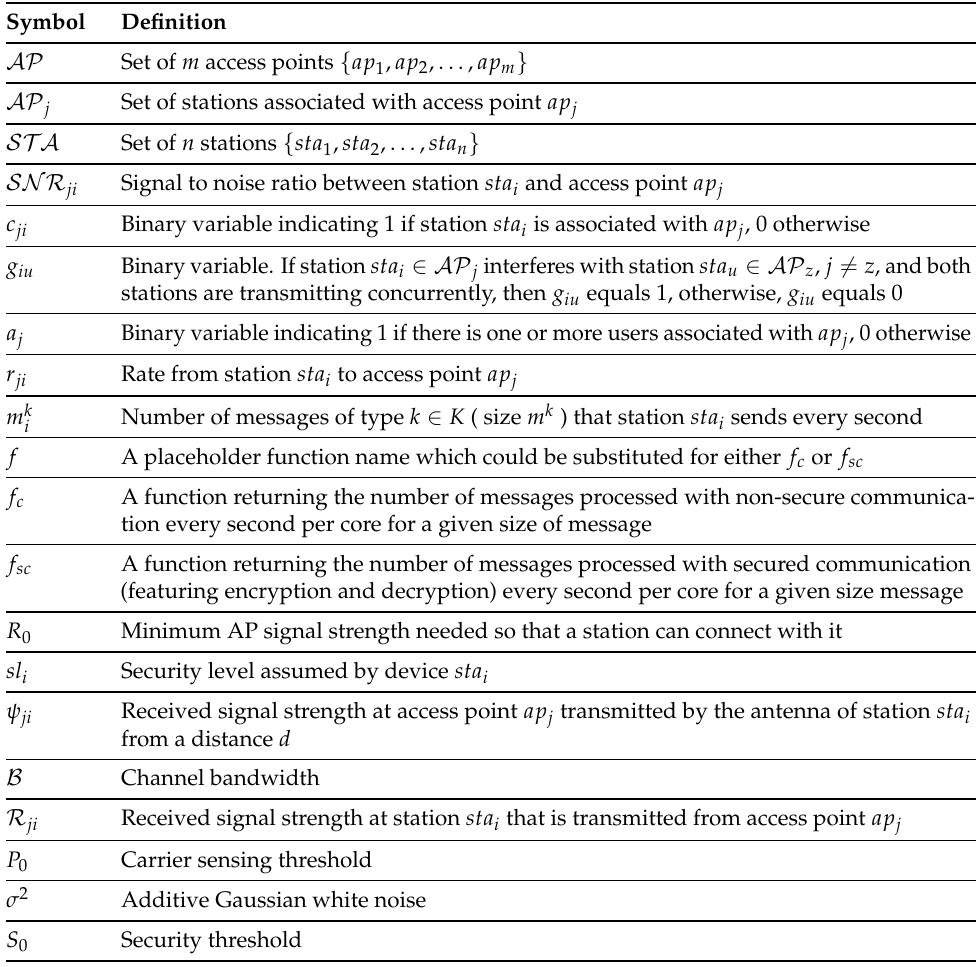
Table 2. Physical meanings of key